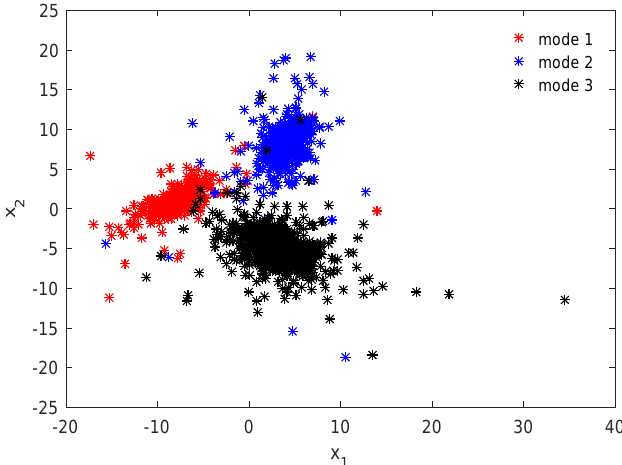
Figure 3. Visualization of the data distribution in the input